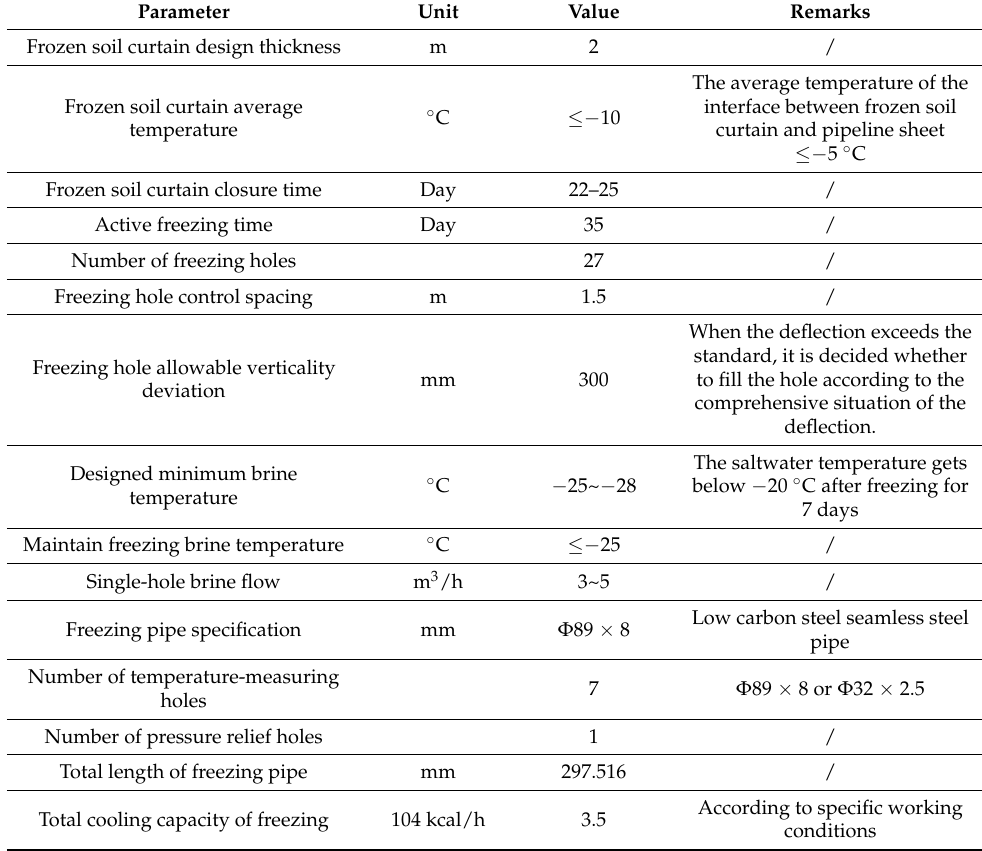
Table 2. Operational parameters during ground freezing.